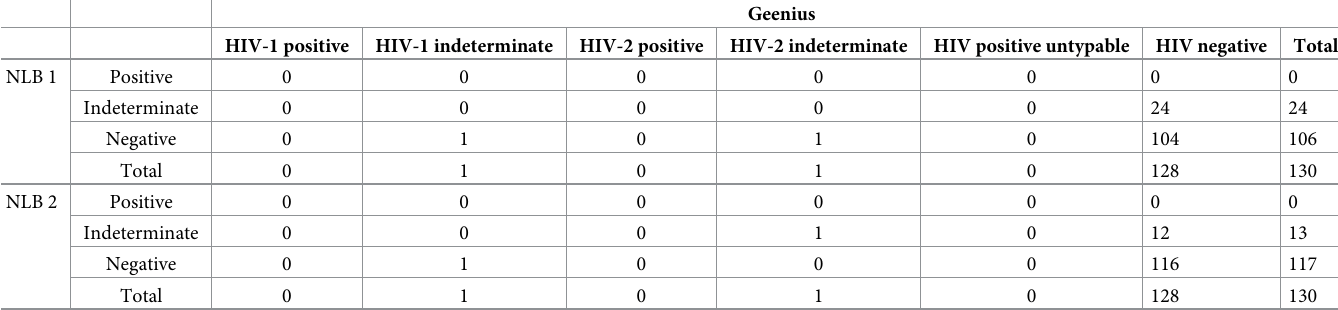
Table 4. Comparison of Geenius with NLB 1 and 2 results for negative samples by fourth-generation immunoassay ( n = 130).